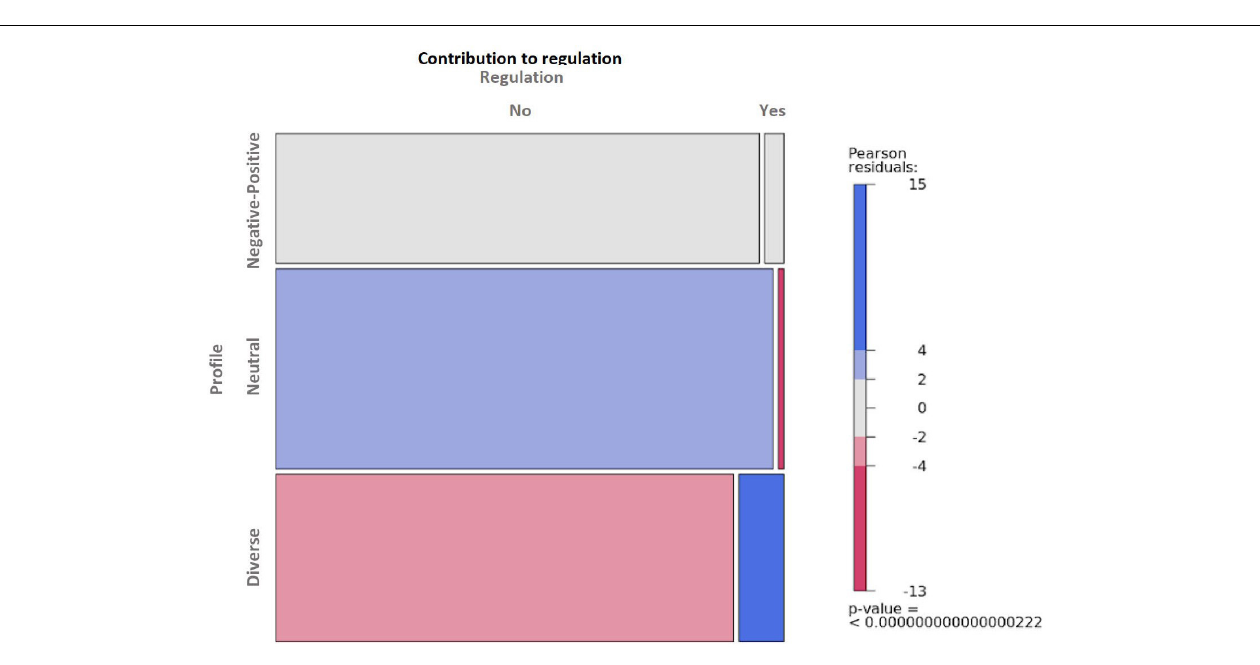
FIGURE 6 | A mosaic plot visualizing the association of the contribution to regulation of learning and the three socio-emotional interaction